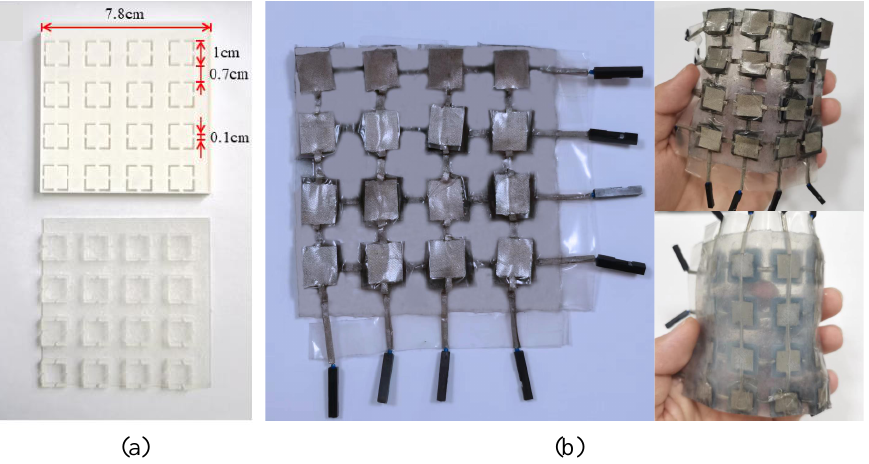
Figure 4. ( a ) A schematic diagram of the mold structure; ( b ) a photograph of the integrated flexible tactile sensor